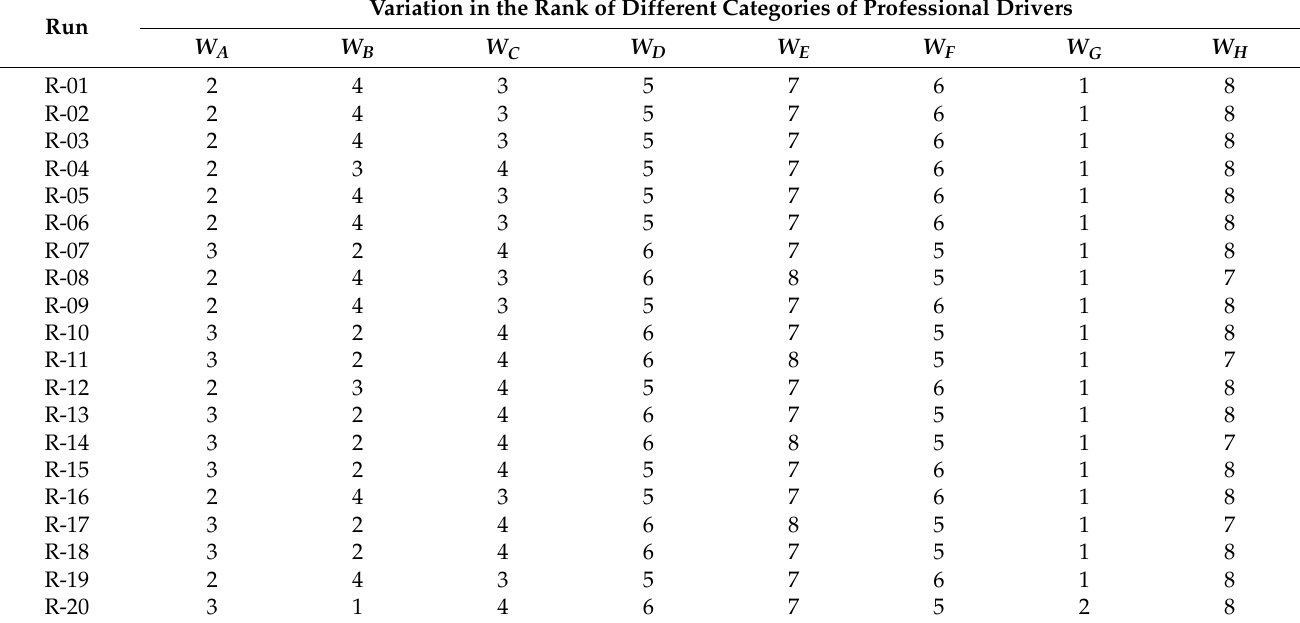
Table 15. Modified ranking of different categories of professional drivers due to change in experts’ rank.